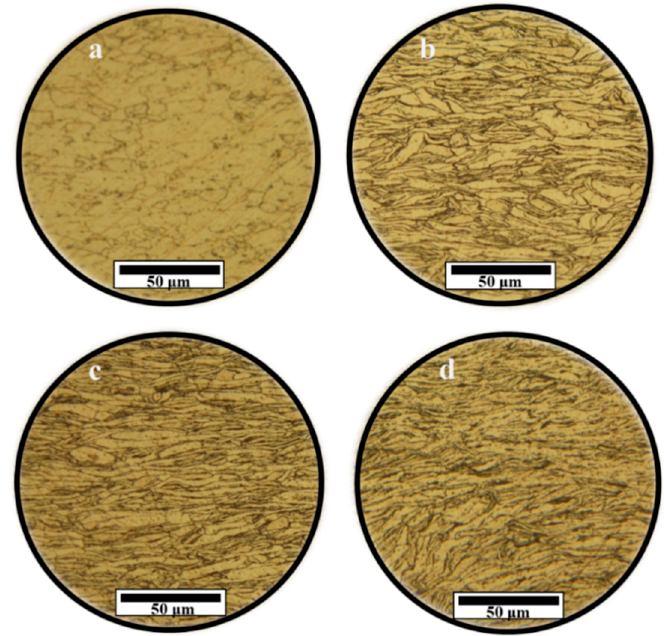
Figure 4. LOM images of ECAPed specimens after etching: ( a ) Aluminum; ( b ) Al-0.25 wt.% GNS; ( c ) Al-0.5 wt.% GNS; and ( d ) Al-1 wt.% GNS.